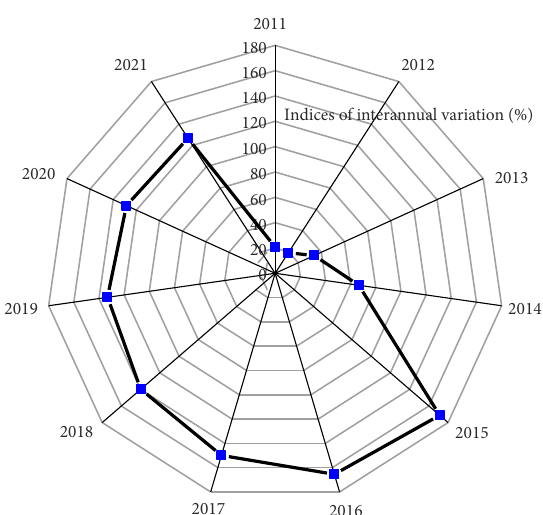
Figure 6. Indices of Interannual